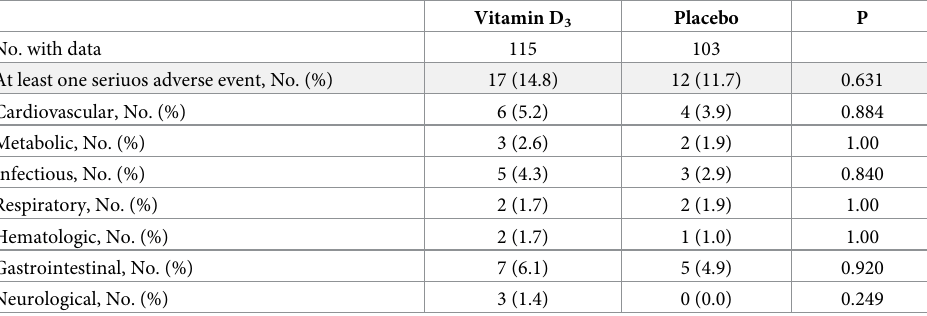
Table 3. Serious adverse